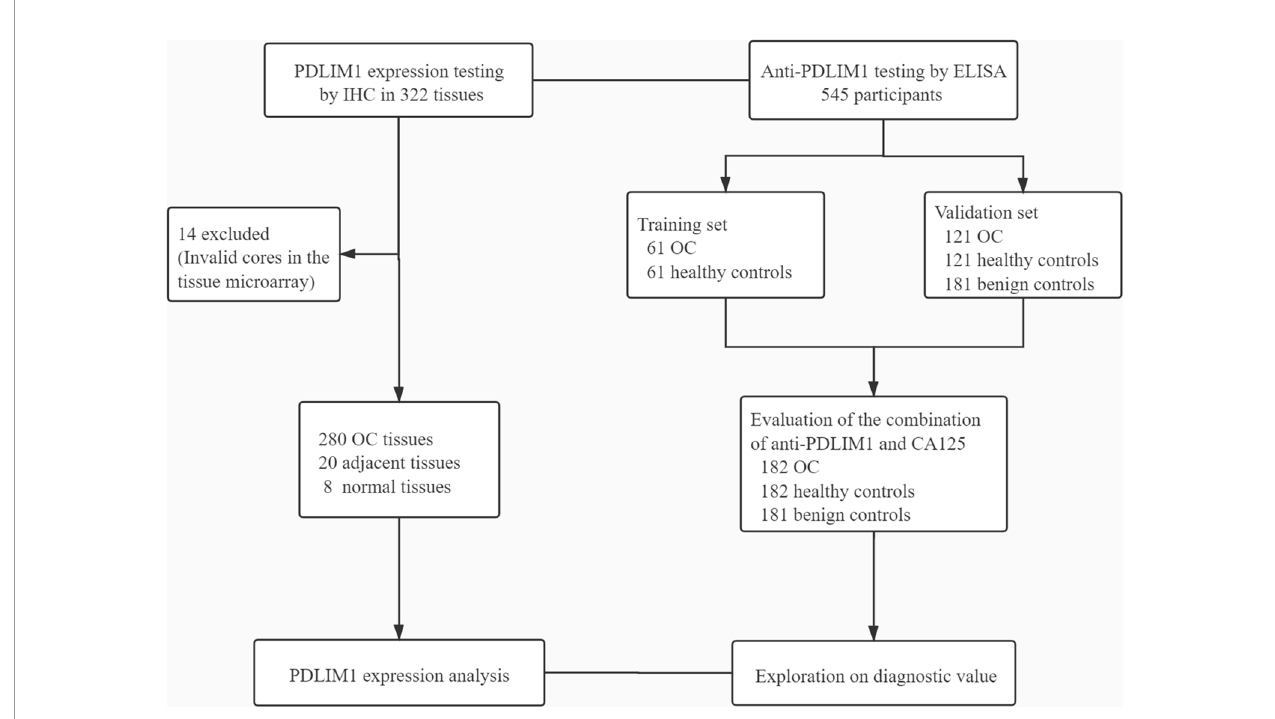
FIGURE 1 | Study design. OC, ovarian cancer; ELISA, enzyme-linked immunosorbent assay; IHC,